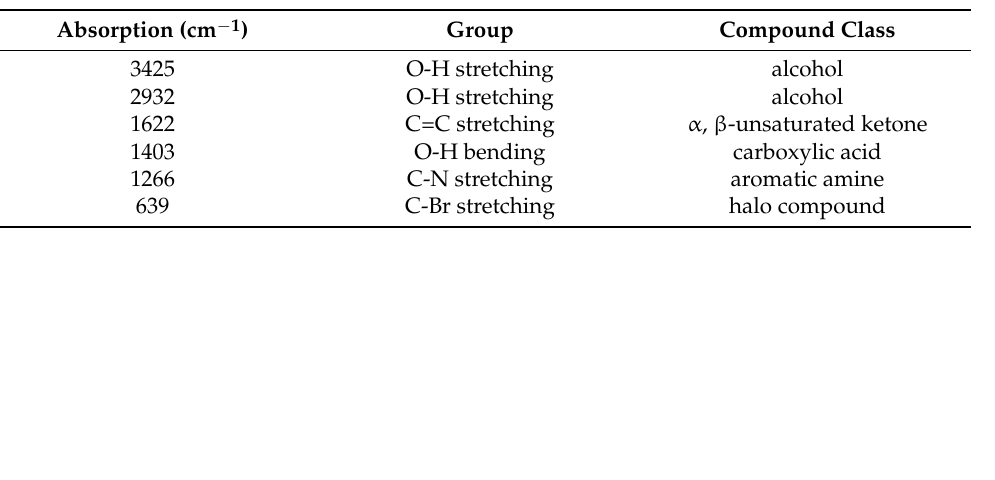
Table 4. FTIR analysis of the water extract of T. aphylla